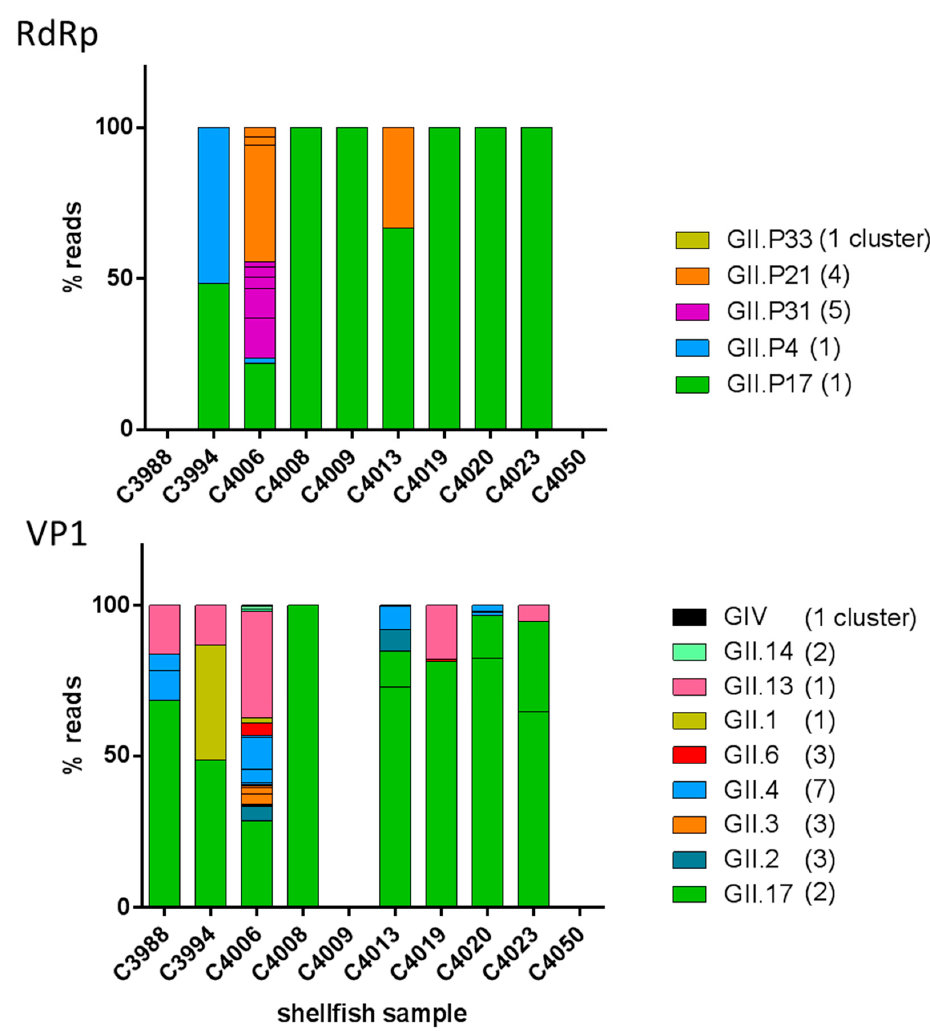
Figure 2. Relative abundance of NoV GII P-types and genotypes identified in the shellfish samples. The proportion of reads belonging to the clusters obtained for RNA-dependent RNA Polymerase (RdRp) (top) and VP1 (bottom) are depicted with the color corresponding to their genotype. The number of clusters obtained per genotype is indicated between parentheses.